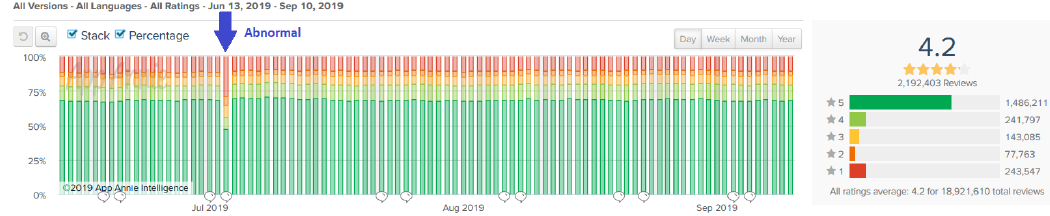
Figure 1. The rating percentage changes of Whatsapp from 13 June 2020 to 10 September